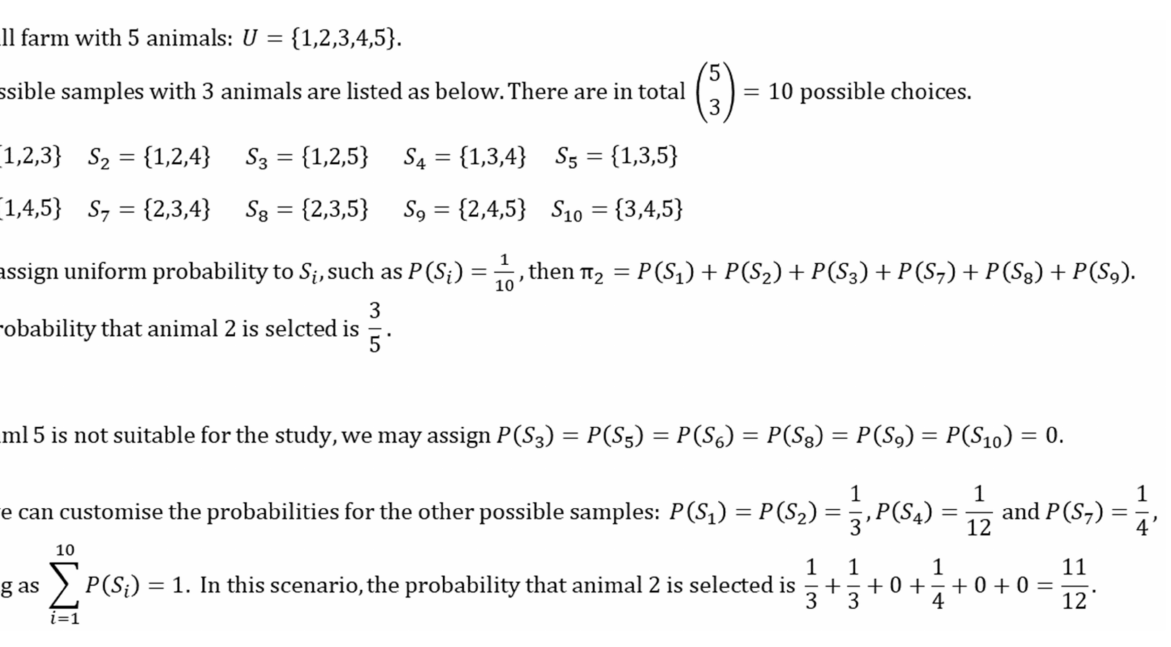
Figure 1. An intuitive explanation of the probability of a sample selection P(S) and the probability of an animal selection π